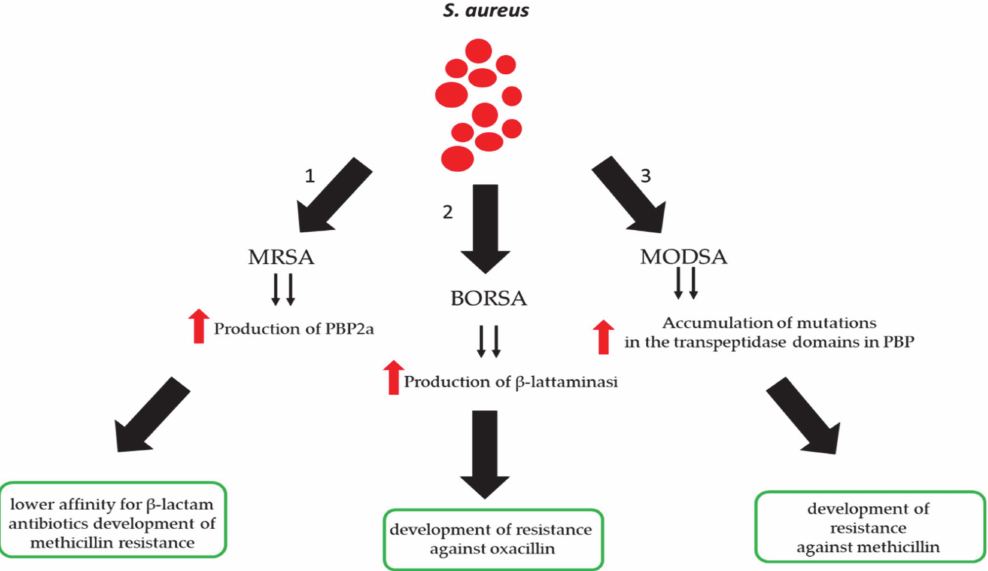
Figure 3. Resistance mechanisms of S. aureus against penicillin. MRSA, methicillin-resistant S. aureus ; BORSA, borderline oxacillin-resistant S. aureus ; MODSA, modified S. aureus